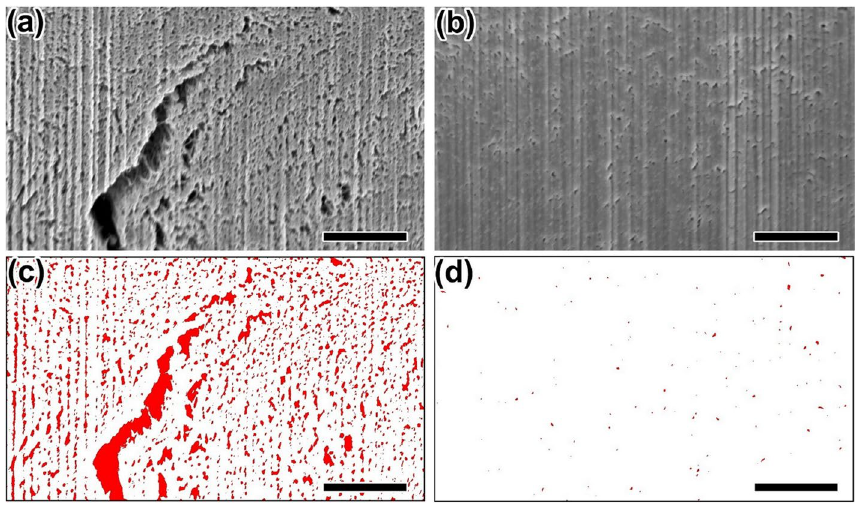
Figure 5. SEM images of the cross-section of ( a ) as-grown CNT bundles and ( b ) CSA-CNT fiber. Binarized images of ( c ) as-grown CNT bundles and ( d ) CSA-CNT fiber. The red areas correspond to inter-tube voids of the fibers. Scale bar: 1 μm. The binarized images were drawn by the ImageJ software (https:// imagej. nih. gov/ ij/).